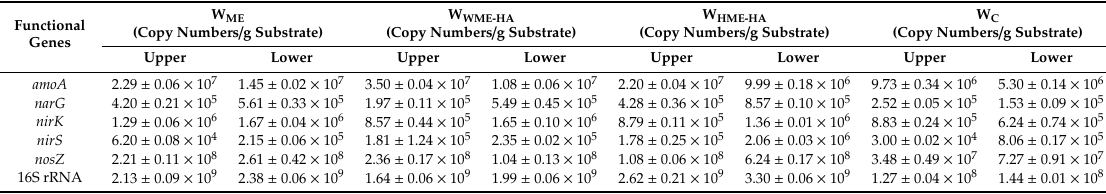
Table 3. The abundances of related functional genes in denitrifying bacteria and nitrifying bacteria (mean ± SD, n =